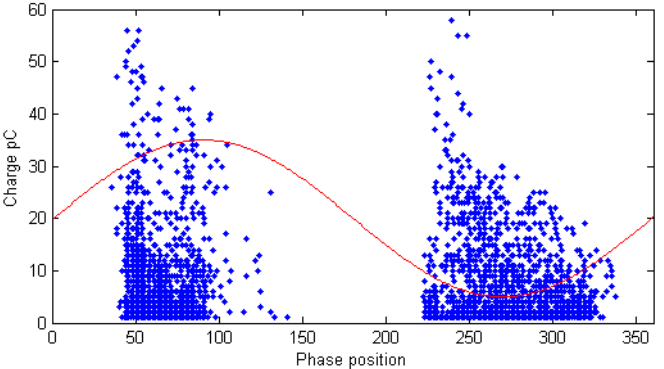
Figure 11. Typical 2D partial discharges (PD) pattern.